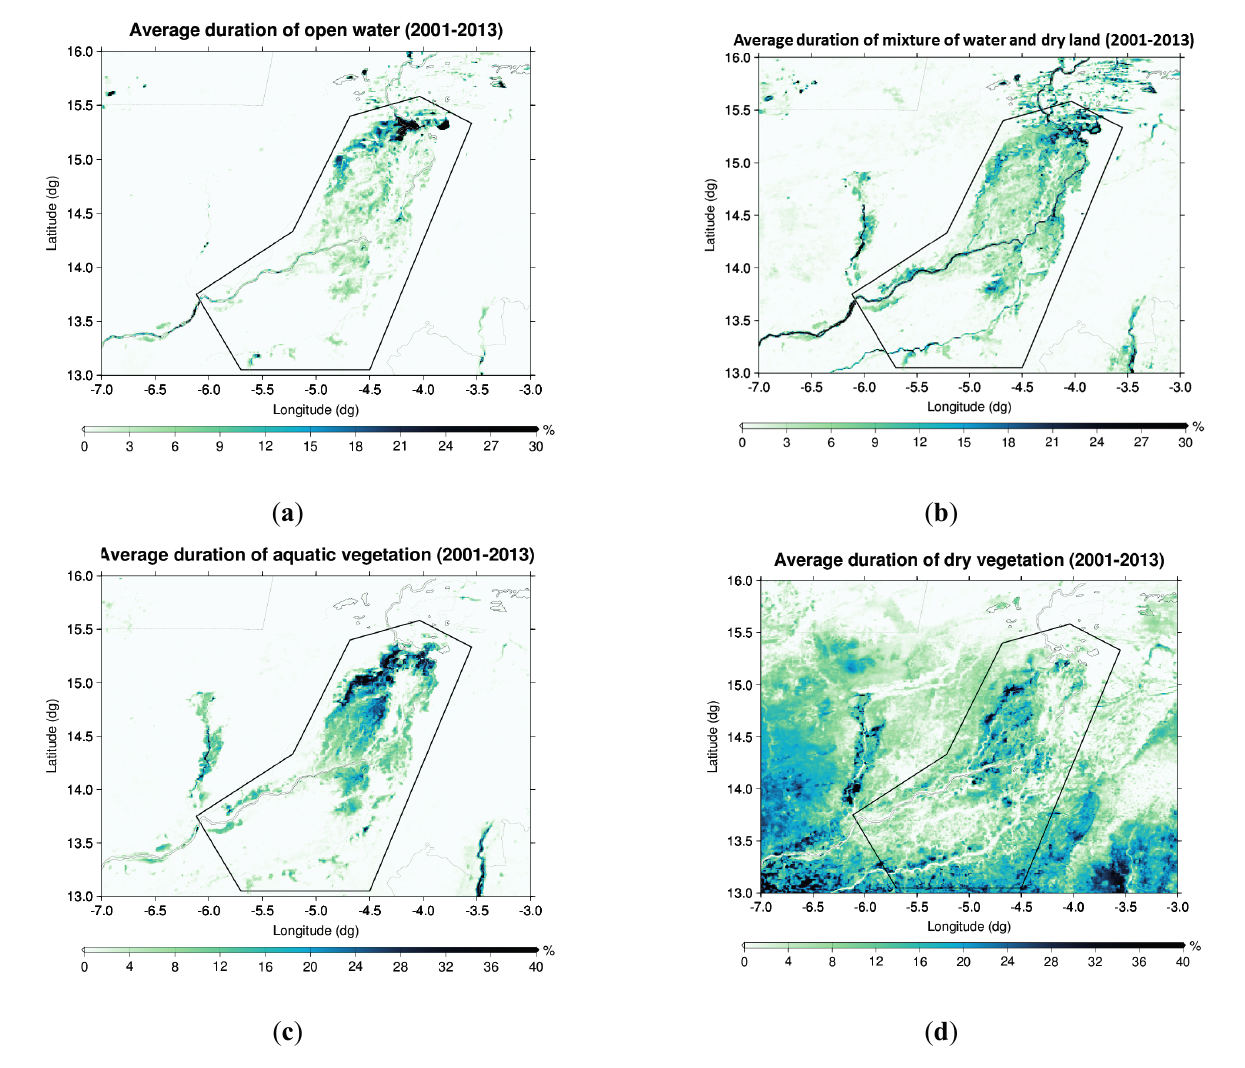
Figure 5. Average duration (in percentage per year) of ( a ) open water; ( b ) mixture of water and dry land; ( c ) aquatic vegetation; and ( d ) vegetation calculated from 2001 to 2013 (2000 has not been taken into account because the first MODIS data was collected in February of this